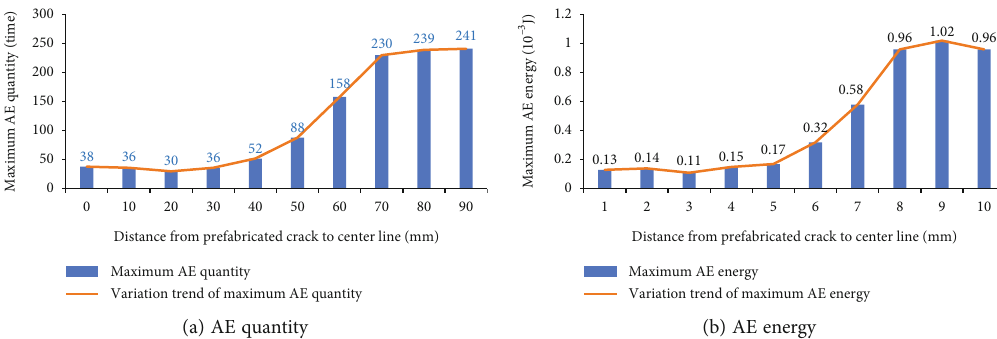
Figure 9: Acoustic emission change curve of concrete three-point bending beam with di ff erent values.